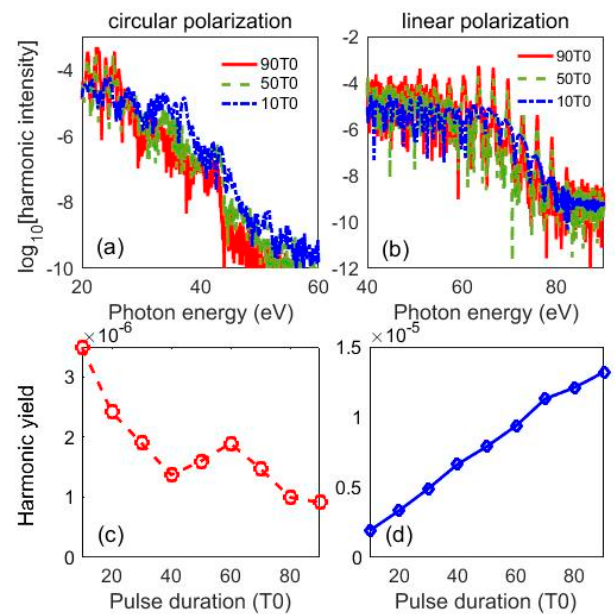
Figure 5. ( a–b ) Pulse-duration dependence of high-order harmonic spectrum for circularly polarized ( a ) and linearly polarized ( b ) sine-squared laser fields. The intensity and wavelength of the laser fields are fixed at 1.0 × 10 14 W/cm 2 and 800 nm, respectively. ( c – d ) Pulse-duration dependence of integrated harmonic yields for circularly polarized laser field from 27.19 eV to 37.19 eV ( c ) and linearly polarized laser fields from 56.67 eV to 66.67 eV ( d).